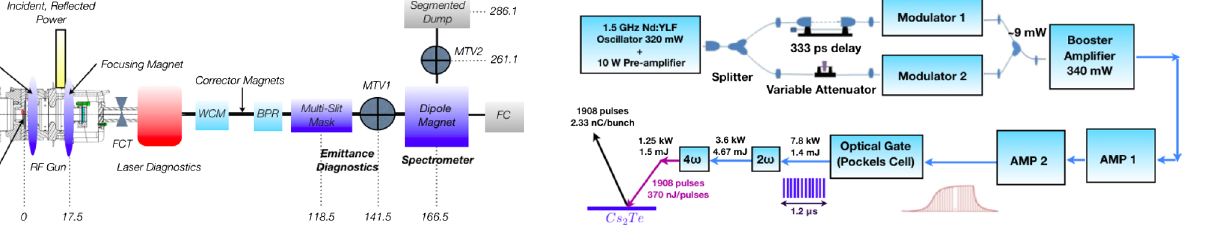
FIG. 2. The schematic layout of the laser system for